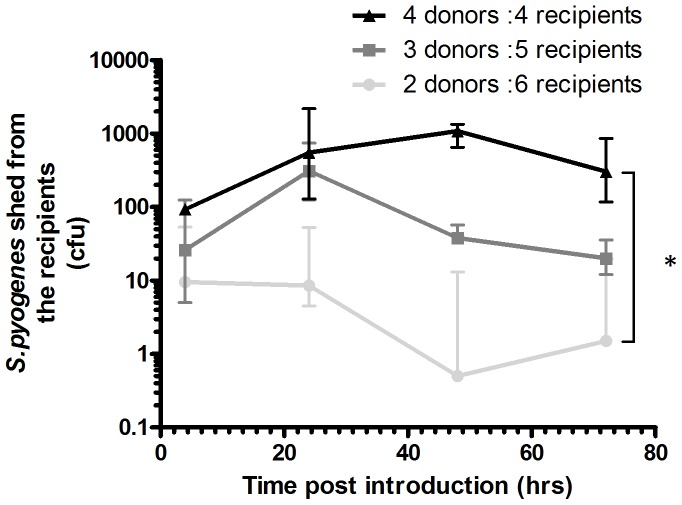
Density of infected carriers determines the burden of transmitted infection.Five week old female FVB/n donor mice infected intranasally with S. pyogenes (1.63×108 cfu per dose) were introduced into a cage of naïve recipient female mice. The Donor: Recipient (D:R) ratio was varied between 4∶4, 3∶5 and 2∶6 between cages. Recipient mice were sampled at 4, 24, 48, 72 and 96 hours after the infection and introduction of the donor mice to a cage. Data show counts from direct nasal sampling from recipient mice only. Donor mice had >5000 cfu recovered at all time points (not shown). The burden of transmitted infection was significantly higher in cages with a D:R ratio of 4∶4 compared with cages with a 2∶4 ratio. (AUC analysis, followed by Kruskal Wallis with Dunns Post test p<0.05). Lines indicate the median and the interquartile range.